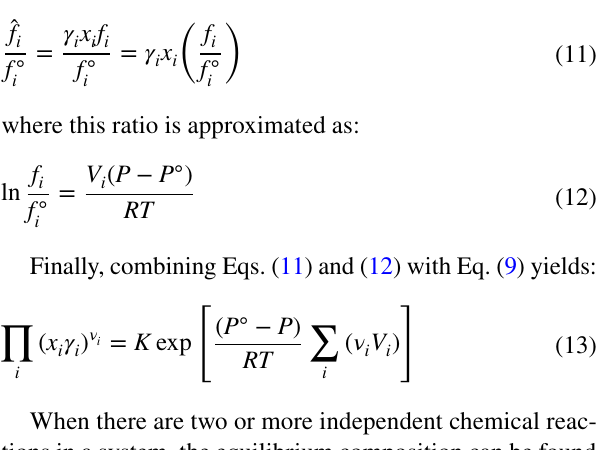
Table 3 Initial and reservoir conditions for studying H